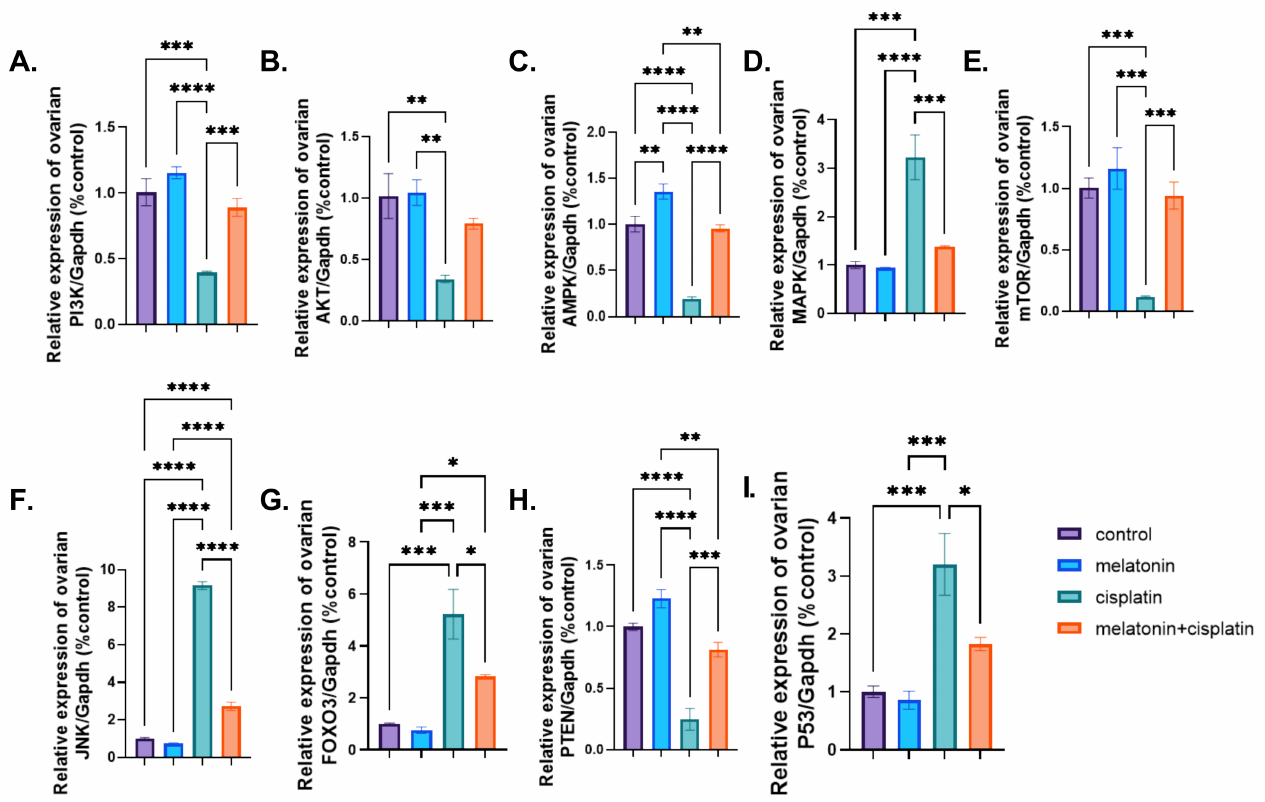
Figure 12. Effect of melatonin administration in cisplatin-induced ovarian impairment in female rats on ovarian PI3K-Akt/mTOR/AMPK signaling pathway ( A – I ). ( A ) Ovarian PI3K/ Gapdh (% control), ( B ) ovarian Akt/ Gapdh (% control), ( C ) ovarian AMPK/ Gapdh (% control), ( D ) ovarian MAPK/ Gapdh (% control), ( E ) ovarian mTOR/ Gapdh (% control), ( F ) ovarian JNK/ Gapdh (% control), ( G ) ovarian FOXO3/ Gapdh (% control), ( H ) ovarian PTEN/ Gapdh (% control), and ( I ) ovarian P53/ Gapdh (% con- trol). Data are expressed as means ± SEM. n = 8. *, **, ***, **** indicate significant difference ( p < 0.05, p < 0.01, p < 0.001, and p <